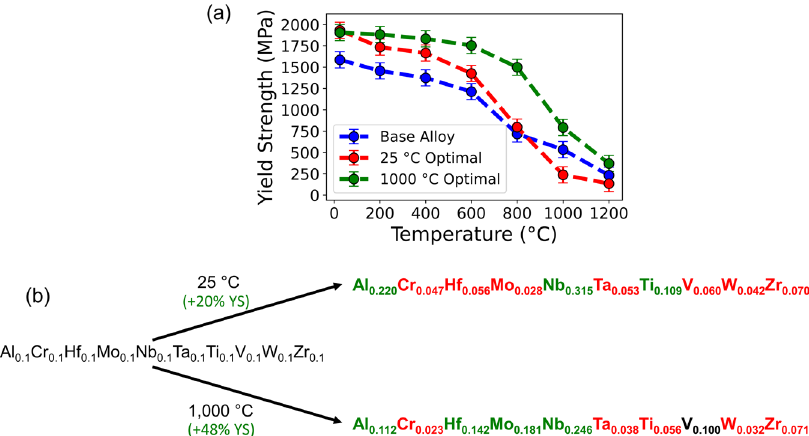
Fig. 6 Composition optimization of a 10-element alloy system for 25 °C and 1000 °C. a Temperature-dependent yield strength, and ( b ) corresponding changes in elemental composition starting from the equimolar base alloy and optimizing at 25 °C and 1000 °C. A 95% con fi dence level error (±94 MPa) is shown for